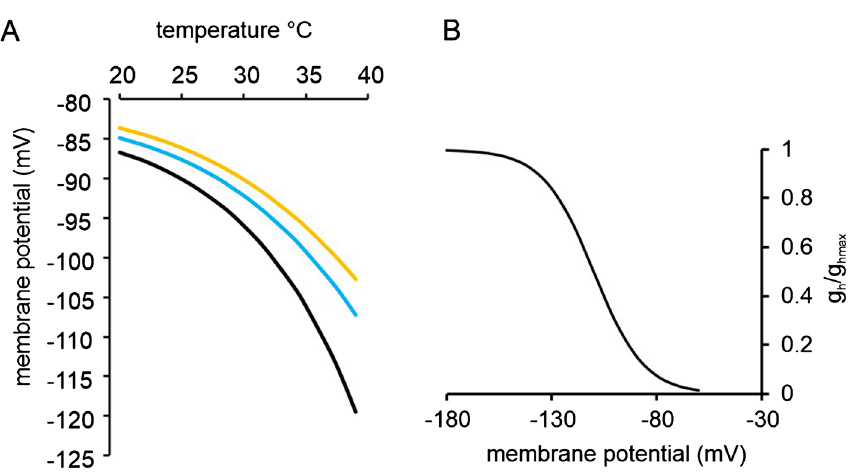
Figure 5. Changes in membrane potential associated with a temperature-dependent electroneutral influx of Na + ions, is modified by I h . ( A ) where I EN , the return pump-current associated with the electroneutral influx, is set to 8 pA at 20 °C and increasing temperature increases electroneutral entry, with an assumed Q 10 of 3 (without I h , black curve). Maximal activation of I h increases membrane conductance by 100% (yellow curve), or by 50% (blue curve). ( B ) I h activation curve plotted against membrane potential. As the membrane potential hyperpolarizes, Ih is activated